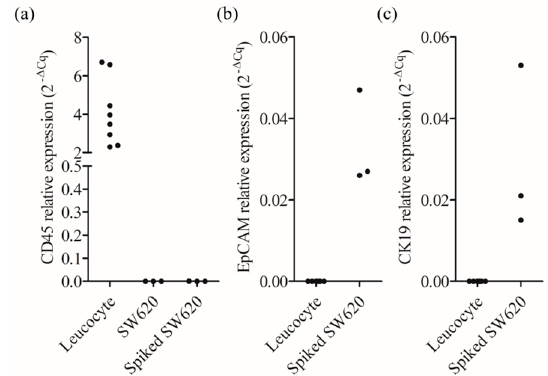
Figure 4. Analysis of the gene (( a ) leucocyte-specific CD45 and cancer cell-specific ( b ) EpCAM and ( c ) CK19 genes) expression levels in the pure leucocytes, the SW620 cancer cells, and the cells isolated by the proposed method.